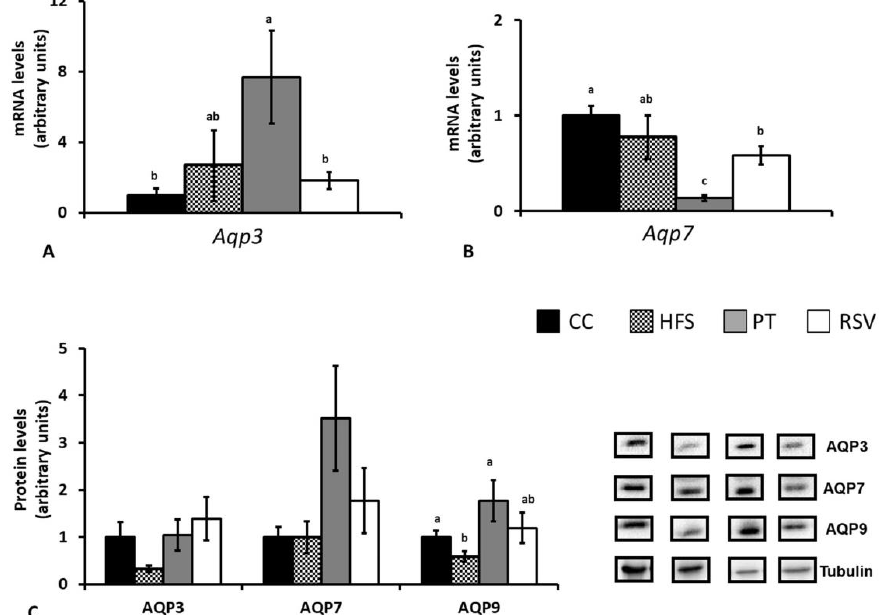
Figure 6. Subcutaneous adipose tissue aquaglyceroporin gene ( A , B ) and protein ( C ) expression. Different letters indicate statistically significant differences. Aqp3 and AQP3: aquaglyceroporin 3, Aqp7 and AQP7: aquaglyceroporin 7, Aqp9 and AQP9: aquaglyceroporin 9.